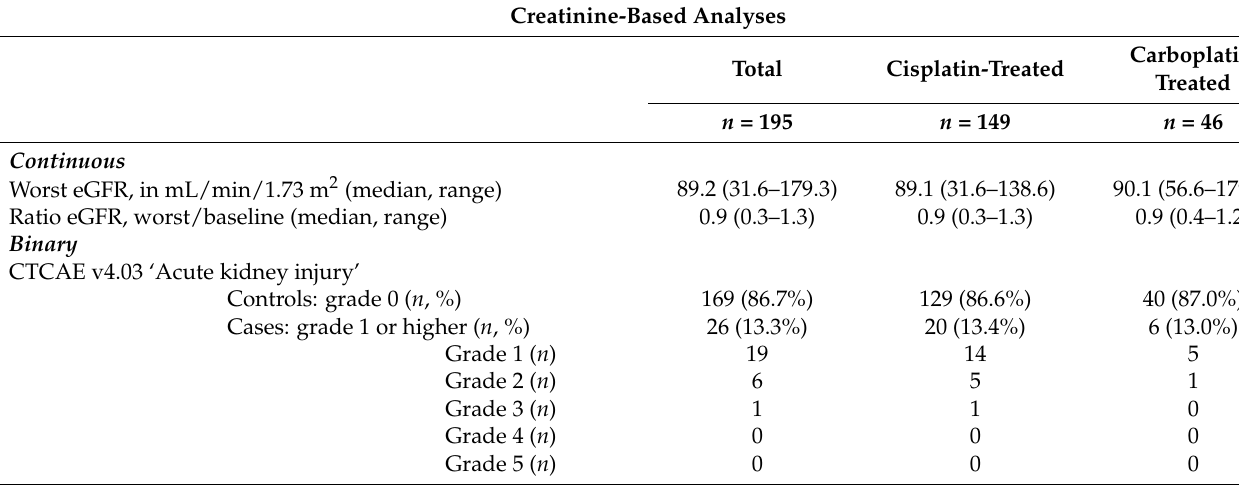
Table 2. Characteristics of nephrotoxicity